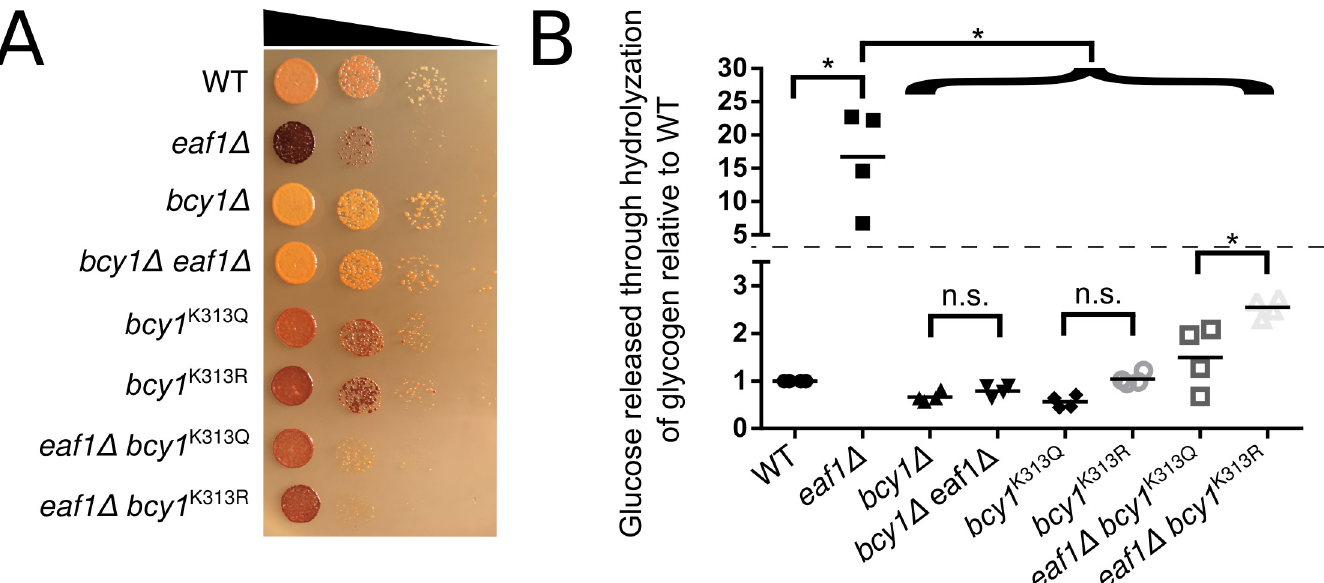
Fig 8. Bcy1-K313Q/R mutants partially suppress glycogen accumulation of eaf1 Δ cells. ( A) Cellular glycogen levels was assessed using iodine staining. The indicated strains were serially diluted on to YPD plates, grown at 30˚C for 24 hours prior to exposure to iodine crystals. Darker staining represents more glycogen within the cell. Image is representative of three independent dot assays. (B) Cellular glycogen content was assessed by measuring glucose released from hydrolyzation of glycogen. Cellular glycogen was extracted and treated with amyloglucosidase to break down glycogen into glucose. Glucose was then measured directly using the Glucose Colorimetric/Fluorometric assay kit (Biovision, K606). The amount of glucose released through the hydrolyzation of glycogen in each replicate was normalized to that of the WT strain. The Y-axis is broken (horizontal dotted line) in order to best show the data. ANOVA analysis was performed with a Tukey’s multiple comparison test comparing pairs of means. � = p < 0.05, n.s. = p > 0.05, relevant significance bars shown. Horizontal bars in the data represents the mean.